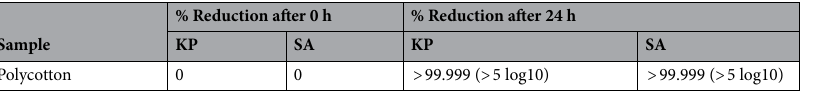
Table 2. Microbial reduction (%) of Klebsiella pneumoniae (KP) and Staphylococcus aureus (SA) after 0 h of incubation (immediate elution) and after 24 h with zinc nanocomposite textiles subjected to 50 wash cycles. Results obtained from third party independent testing (Independent evaluation conducted by Vartest Laboratories